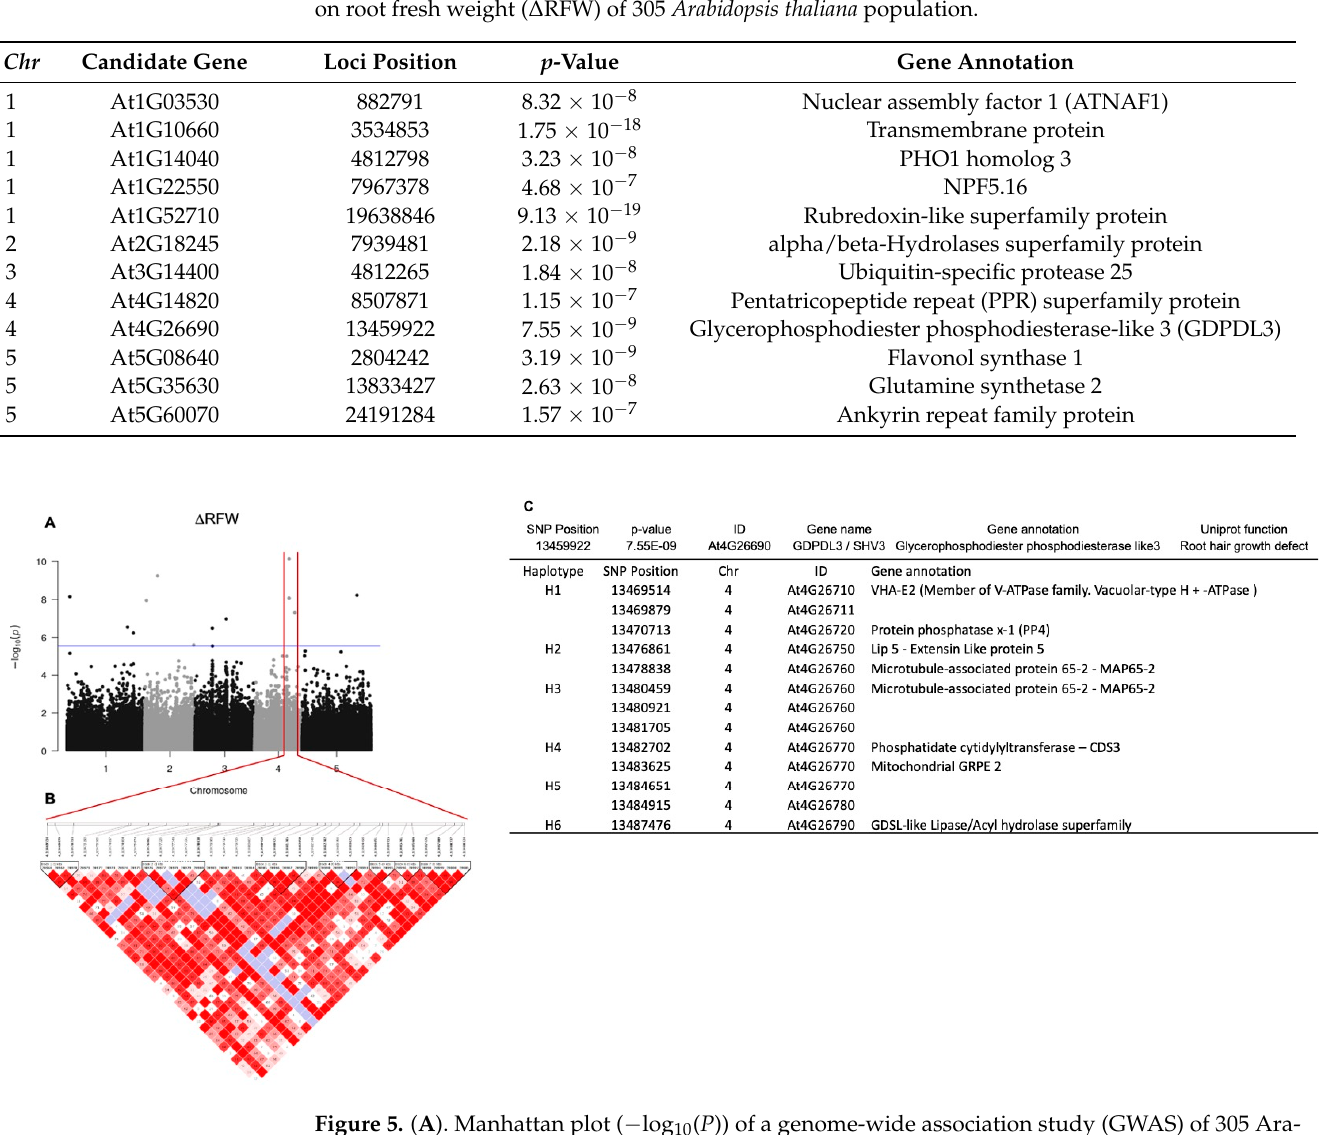
Table 2. List of candidate genes from GWAs analysis of the A. olearius DQS-4 T -mediated plant effects on root fresh weight ( ∆ RFW) of 305 Arabidopsis thaliana population.